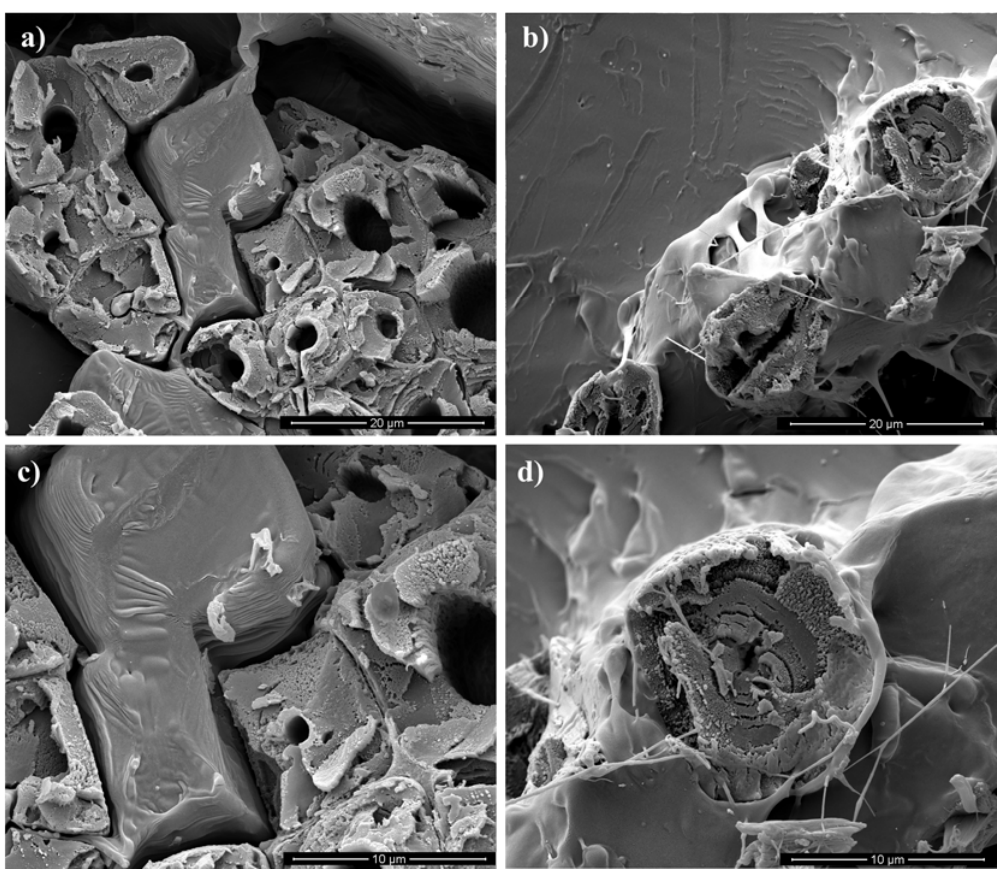
Figure 7. Fracture surfaces of tensile specimens. ( a ) PLA/Flax and ( b ) PLA/Jute at lower magnification; ( c ) PLA/Flax and ( d ) PLA/Jute at higher magnification.